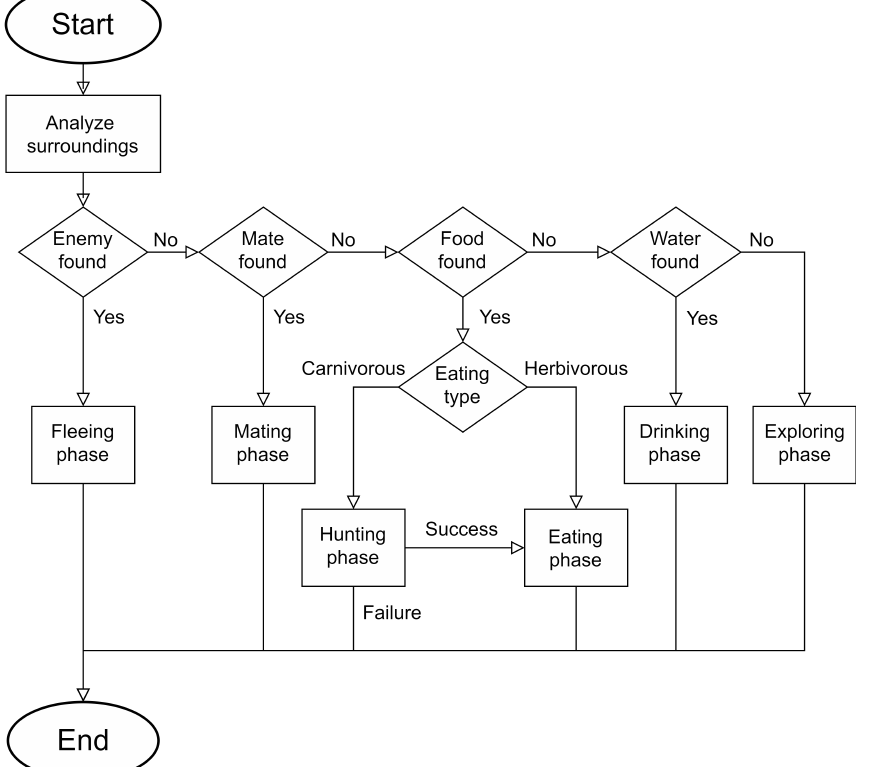
Figure 4. A simplified representation of the animal’s logic. The top (Start) and bottom (End) ellipses represent the boundaries of the algorithm logic. Rectangles represent the different processes, and diamond shapes represent the requirements of the different phase